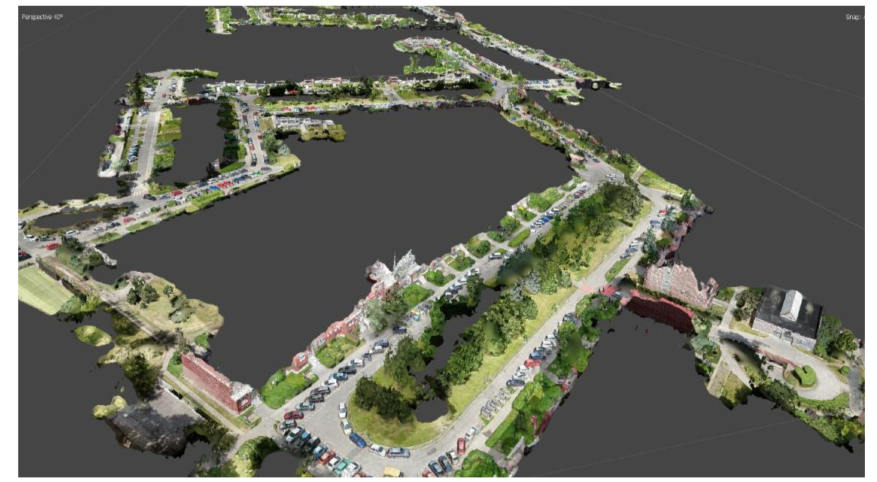
Figure 4. Digital model of the area with